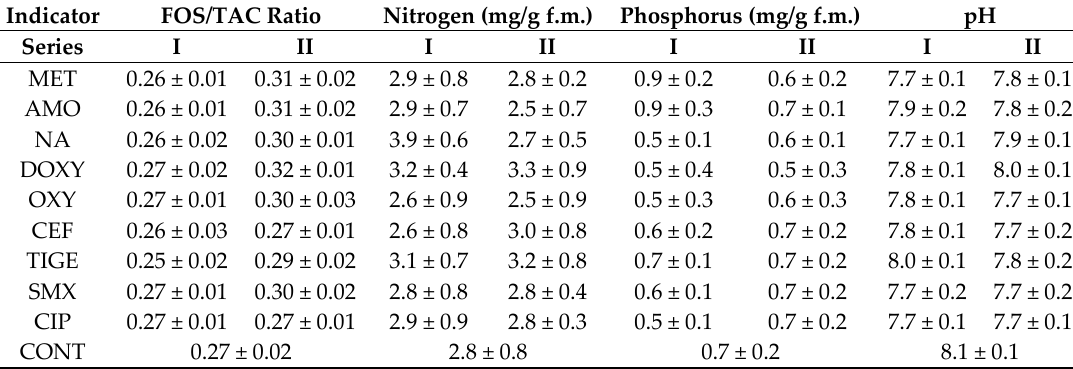
Table 1. The FOS/TAC ratio, concentration of nitrogen and phosphorus, and pH in digestate after biogas production from sewage sludge with antibiotics addition. Abbreviations: MET—metronidazole, AMO—amoxicillin, NA—nalidixic acid, DOXY—doxycycline, OXY—oxytetracycline,